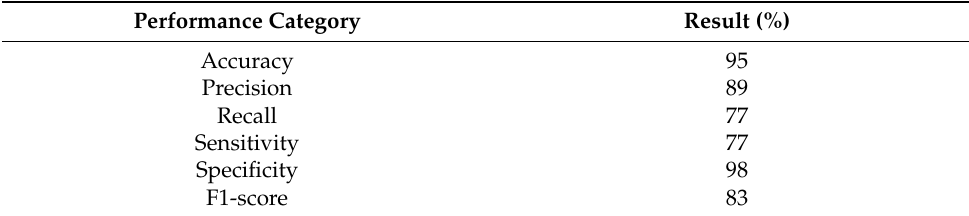
Table 4. COVID-19 CXR Model Performance